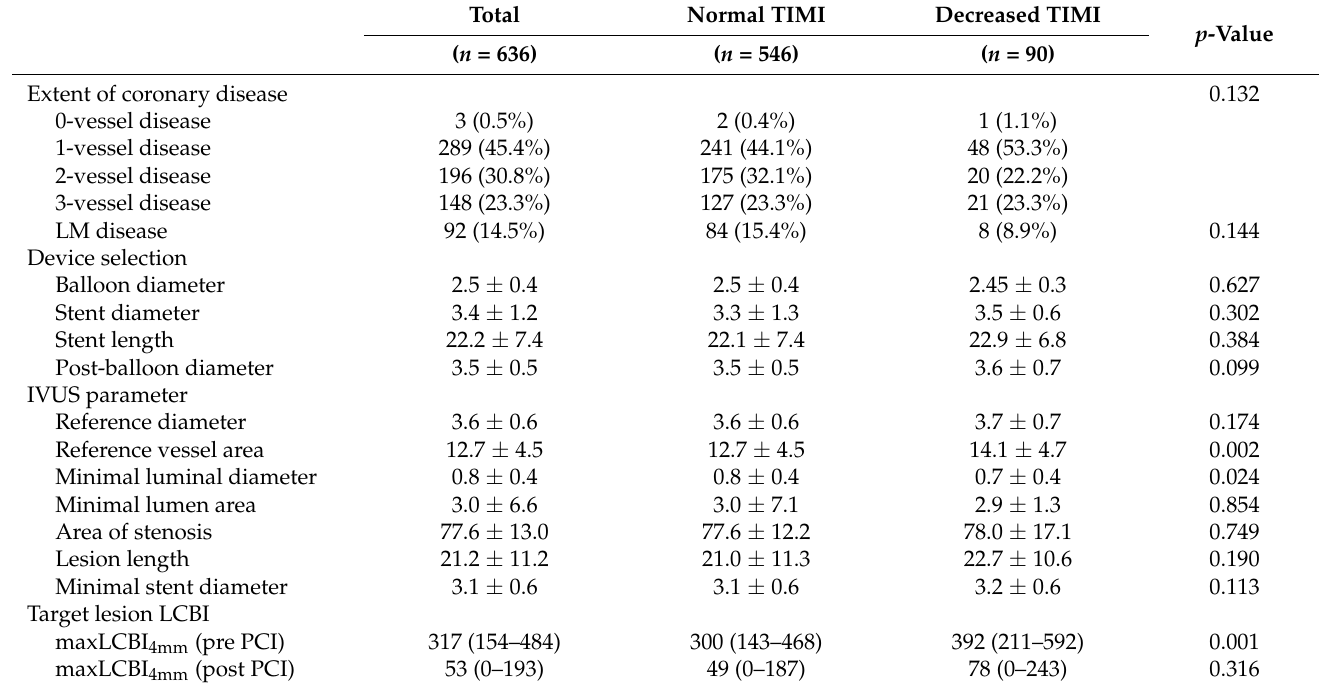
Table 3. Procedural characteristics of study